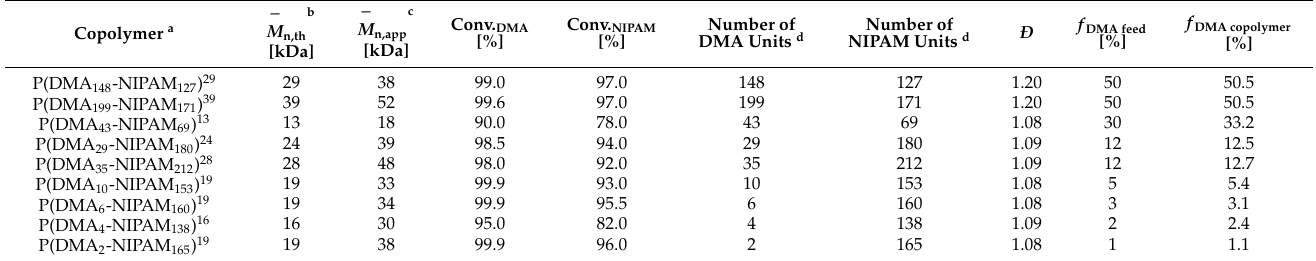
Table 1. Molecular characteristics of the synthesized P(DMA- co -NIPAM) random copolymers, listing the molar DMA fractions of each